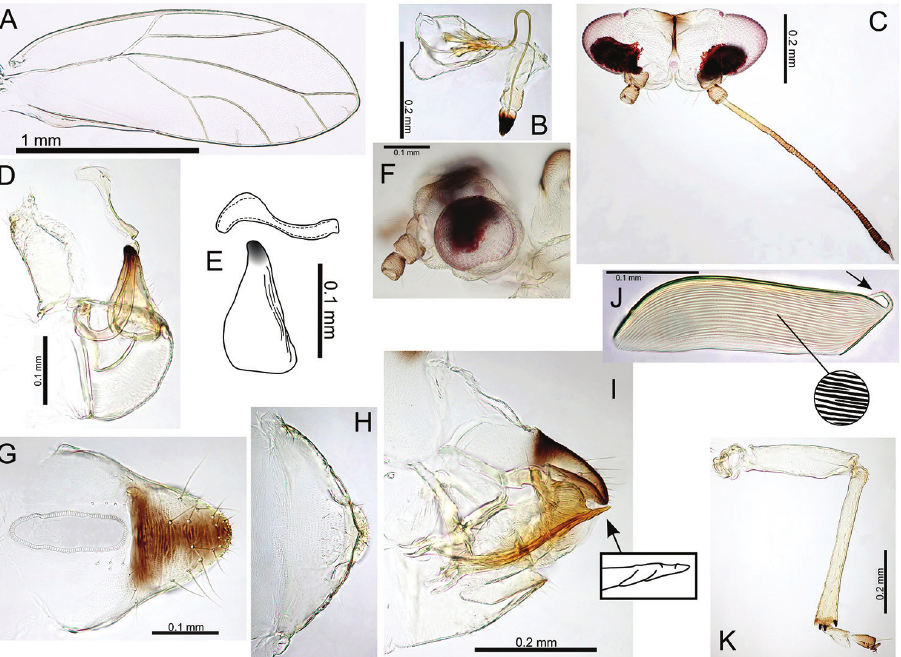
Figure 14. Pariaconus liliha sp. n. A fore wing B proboscis C head and antenna (uncleared ocular tissue) D male terminalia E aedeagus and paramere F head (uncleared ocular tissue) G female proctiger (dorsal view) H female subgenital plate (ventral view) I female terminalia (ovipositor serrations indicated) J egg (tail and striations indicated) K hind leg.